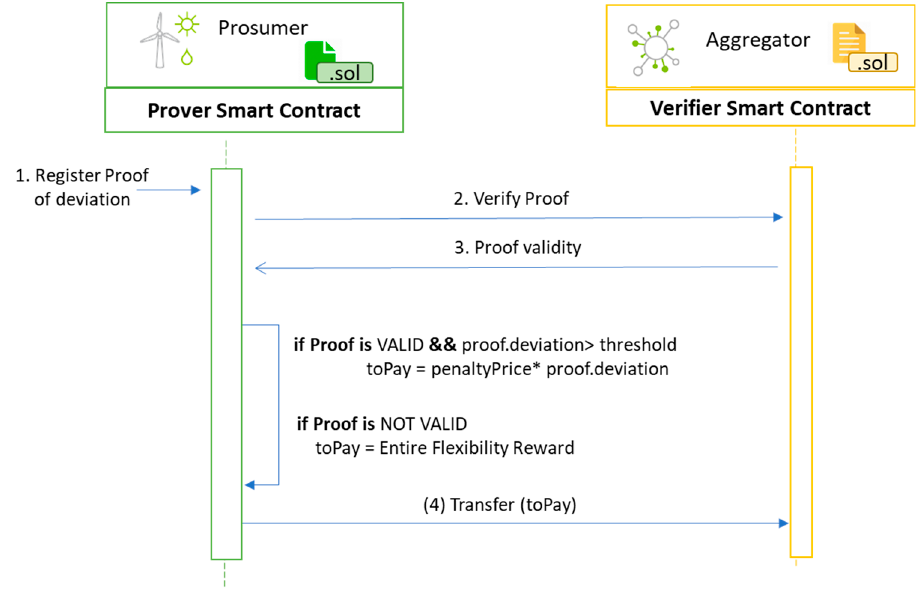
Figure 8. Privacy preserving smart contracts interaction for DR program implementation.